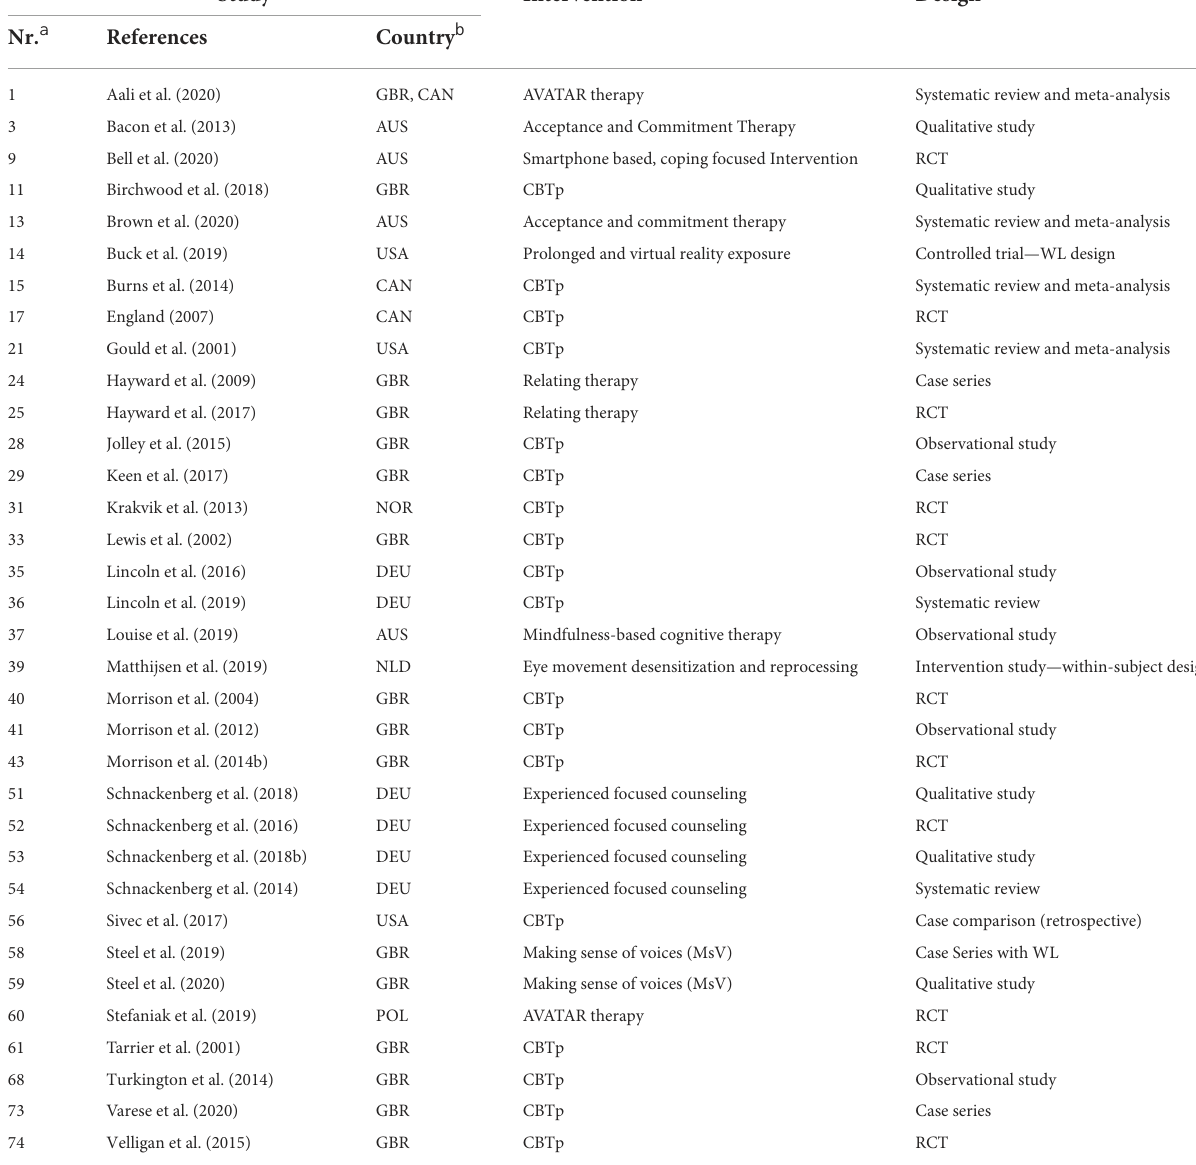
TABLE 1 Overview of articles included in the